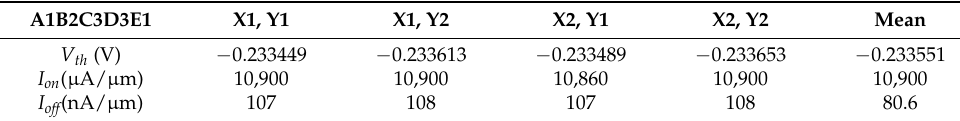
Table 4. Final results of the confirmation run for V th , I on and I off